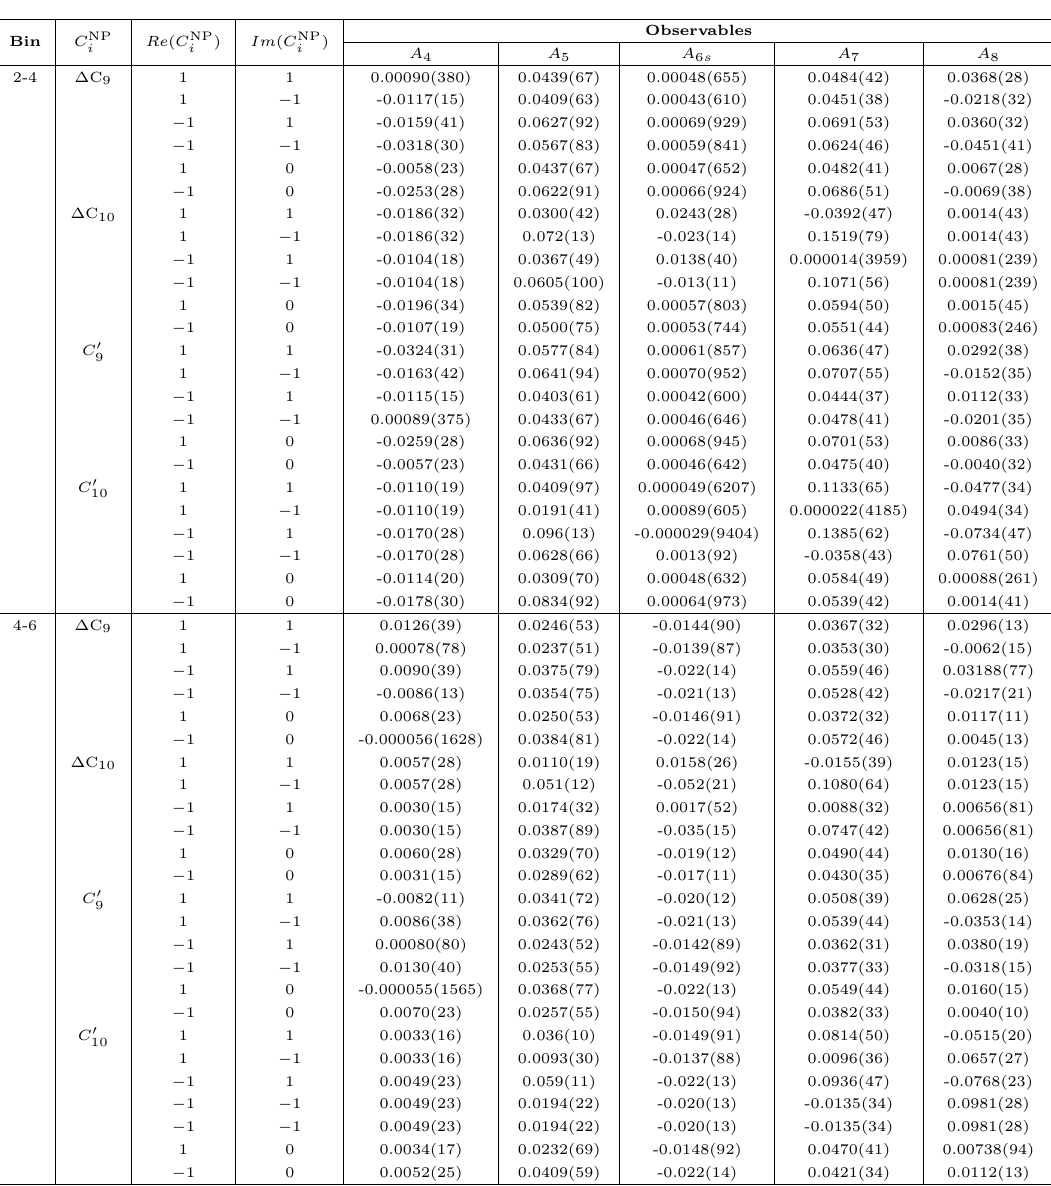
Table 21 . The dependence of the asymmetric observables corresponding to B ± → ρ ± ll on the real and imaginary parts of the NP WC’s ∆ C few benchmark values of the real and imaginary parts of the corresponding